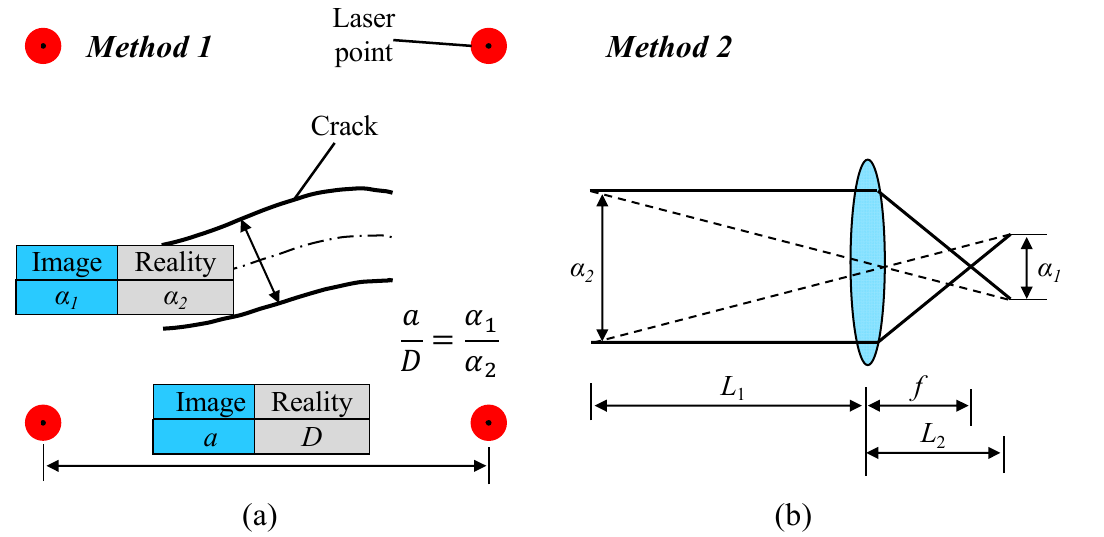
Figure 9. Schematic of the two crack width calculation methods: ( a ) Method 1, ( b ) Method 2. As an essential component of determining the actual crack width, the image crack width α 1 was calculated as follows. As shown in Figure 8, the pixel value of the crack shape area was either 0 or 1, and the borders of the crack were joined by the points with a pixel value of 1. The crack width had to be the smallest distance between two edges, and the distance from the pixel center of one edge ( x n , y m ) to the edge of the other could be